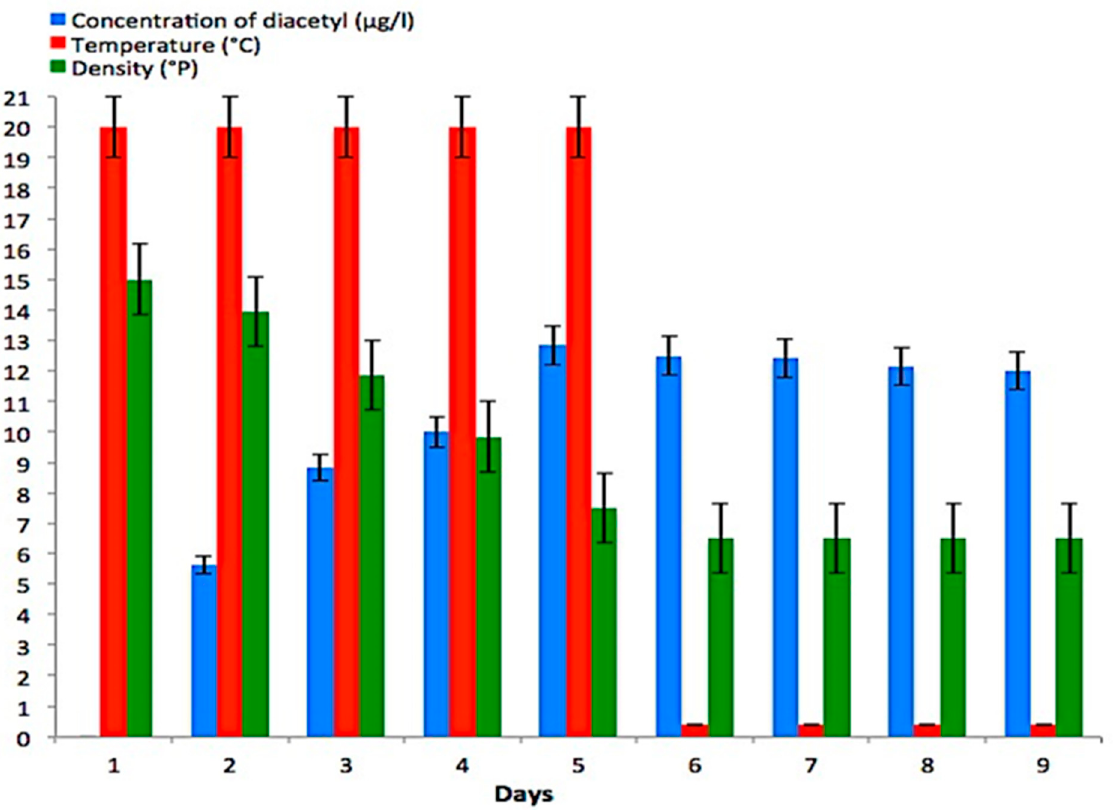
Figure 2. Monitoring of diacetyl concentration during stopping fermentation. Table 5. Aromatic compounds and turbidity of the final product of alcoholic and de-alcoholized beer in various fermentation conditions determined by GC.